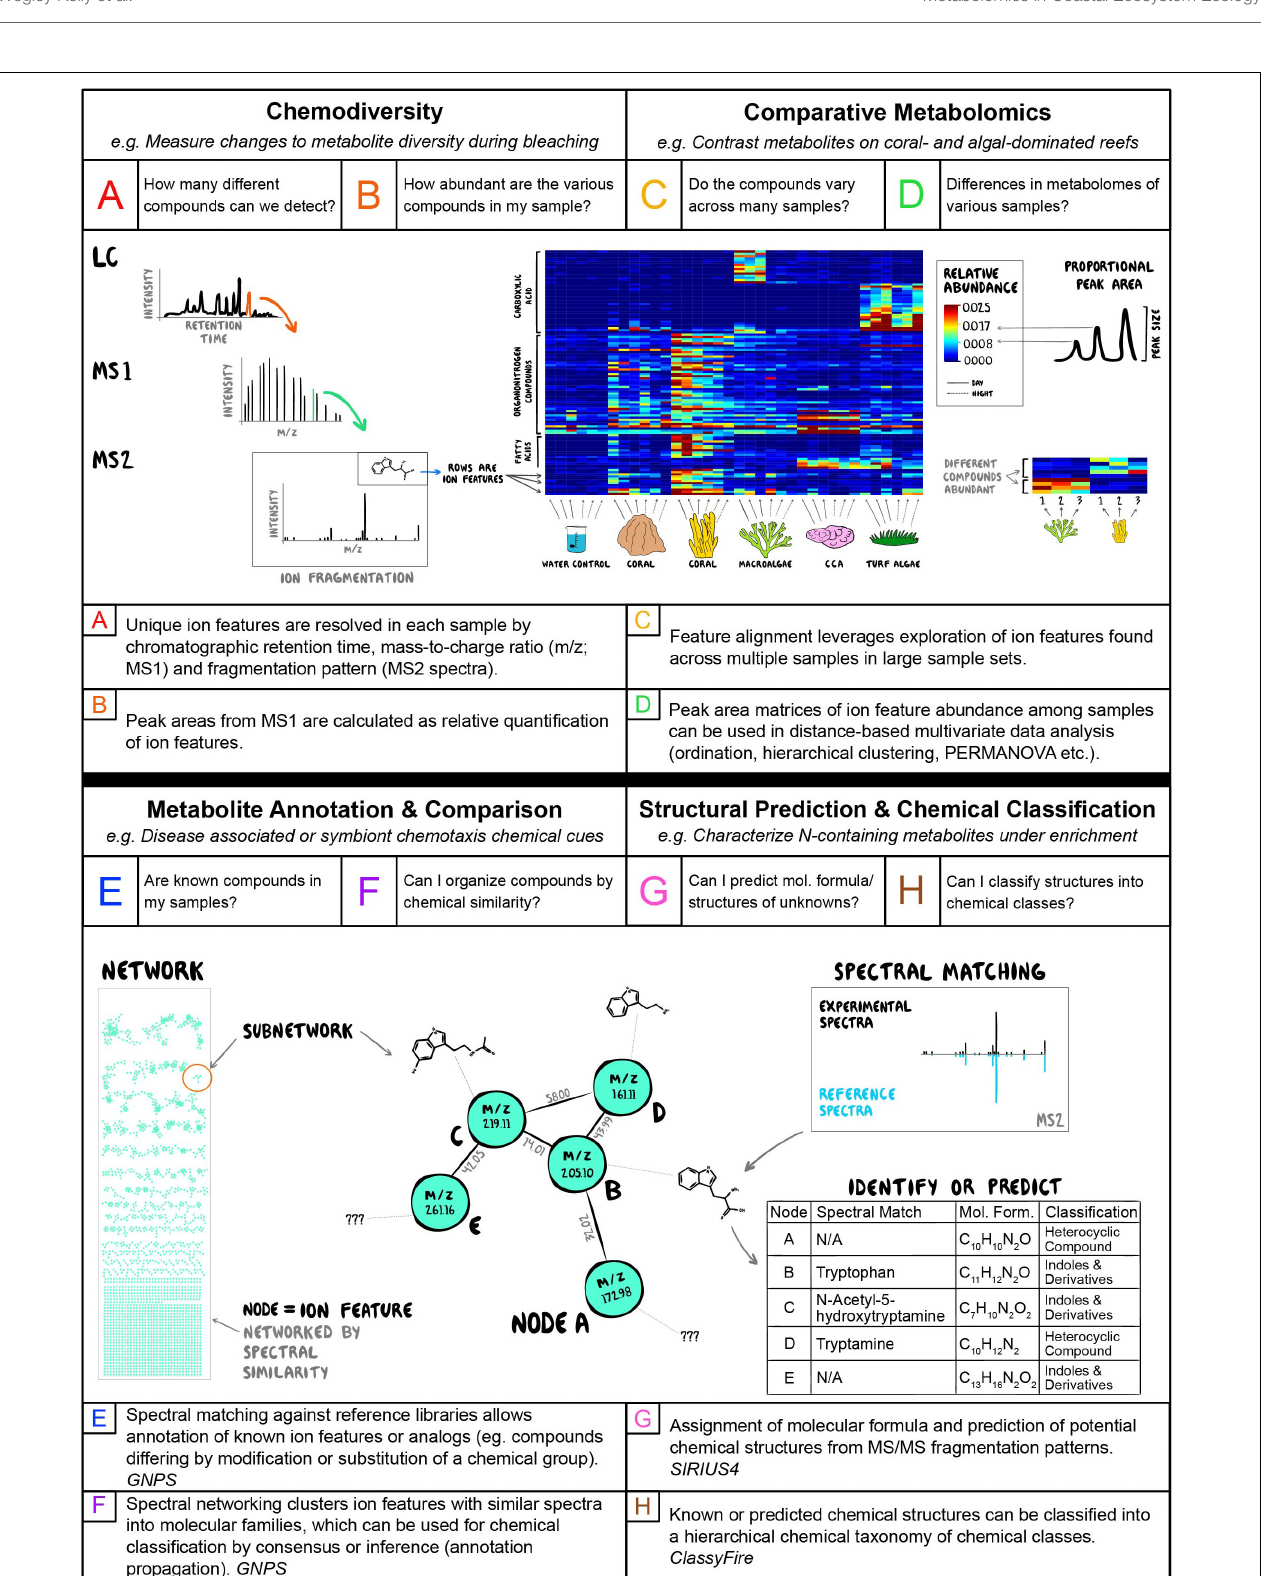
FIGURE 2 | Summary of research areas and tools in coral reef science appropriate for metabolomics analysis, including specific questions asked with metabolomic data ( A–H , top of panels), and example public access tools and informatic workflows recommended ( A–H , bottom of panels).